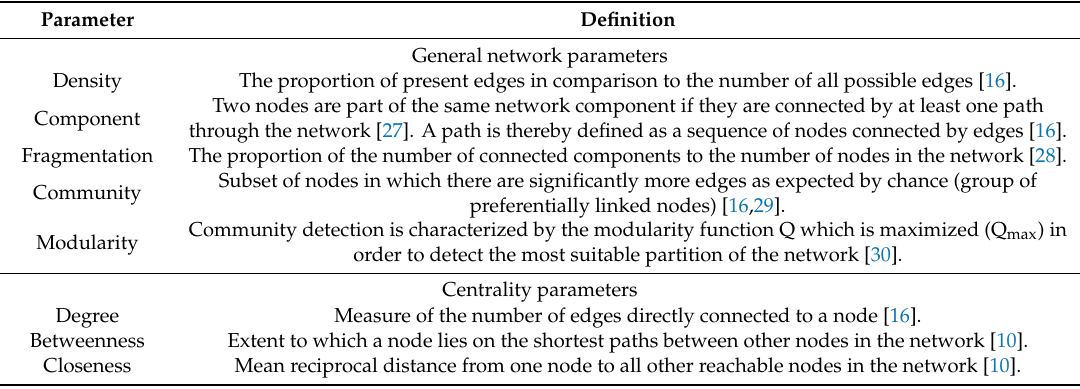
Table 1. Description of the general network parameters and centrality parameters used in the present